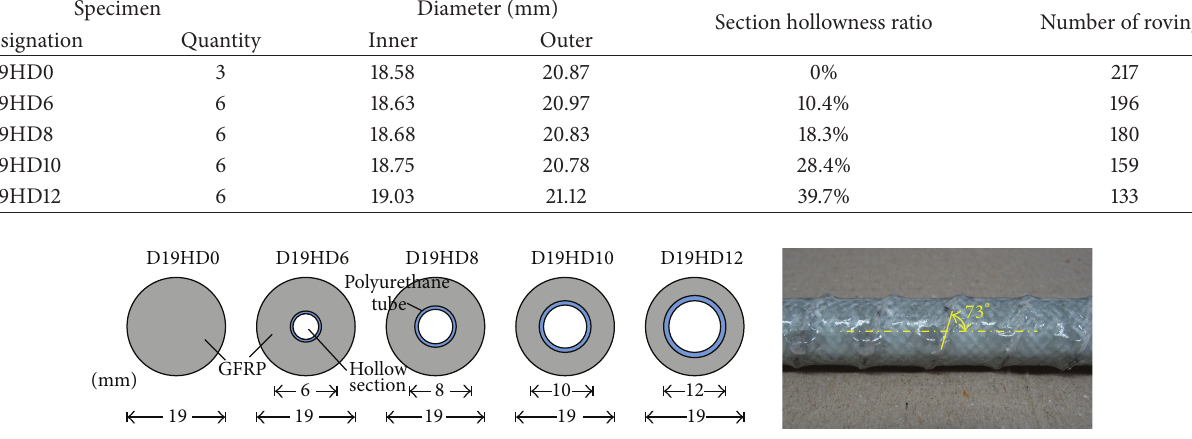
Figure 6: Specification of test specimens.